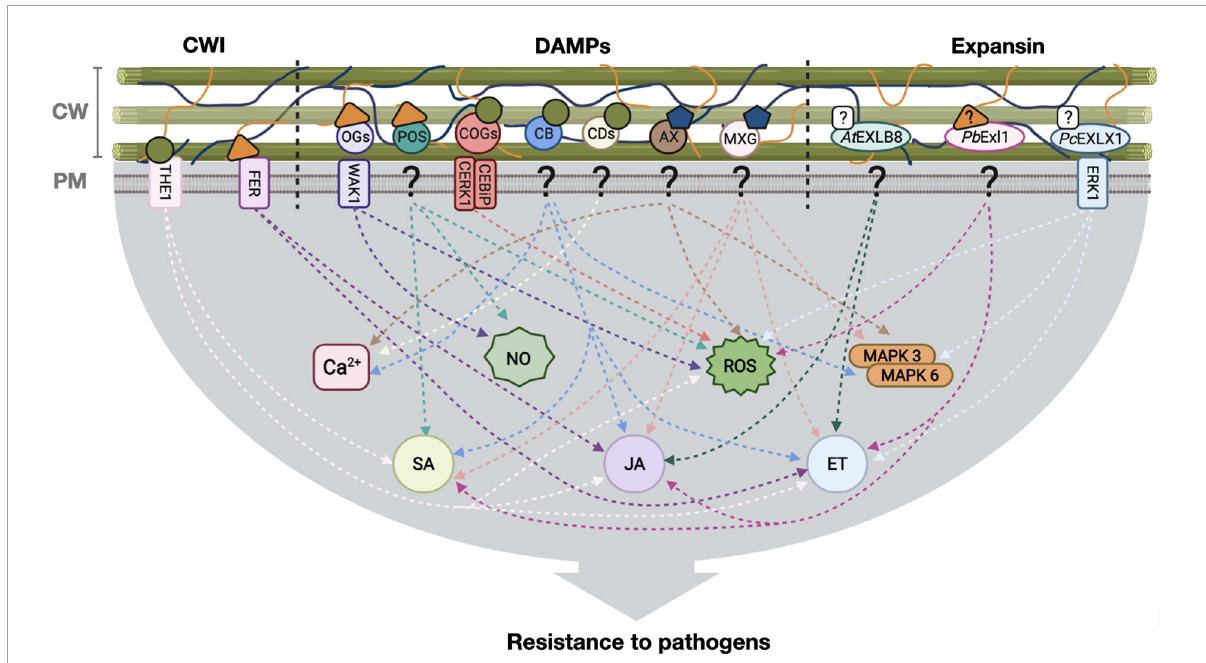
FIGURE1 Defense responses activated by plant cell wall modification for pathogen resistance. Cell wall integrity (CWI) surveillance receptors, DAMPs and expansins interact with plant cell wall components and elicit defense responses leading, in some cases, to pathogen resistance. Stimuli from the cell wall is transduced to the cell interior through different pathways (arrows), for the induction of hormone-dependent signaling, NO, ROS and Ca2 + transients. CW, cell wall; PM, plasma membrane, ?: unknown receptor; OGs, oligosaccharides; POS, pectin oligosaccharides; COGs, cello-oligosaccharides; CB, cellobiose; CDs, cellodextrins; AX, arabinoxylan; MXG, heptamaloxyloglucan; At EXLB8, Arabidopsis thaliana expansin-like B; Pb Exl1, Pectobacterium brasiliense expansin-like 1 protein; Pc EXL1, Phytophthora capsici expansin-like 1 protein; THE1, THESEUS1 receptor; FER, FERONIA receptor; WAK1, WALL ASSOCIATED KINASE 1; CERK1-CEBiP, chitin-elicitor receptor kinase 1-chitin-elicitor binding protein receptor complex; ERK1, expansin-regulating kinase 1; NO, Nitric oxide; ROS, reactive oxygen species; MAPK, mitogen-activated protein kinases; SA, salicylic acid; JA, jasmonic acid; ET, ethylene. Unknown ligand, Cellulose, Hemicellulose, Pectin, Cello-oligosaccharides, Hemicellulose derivatives, Pectin derivatives. Figure created with